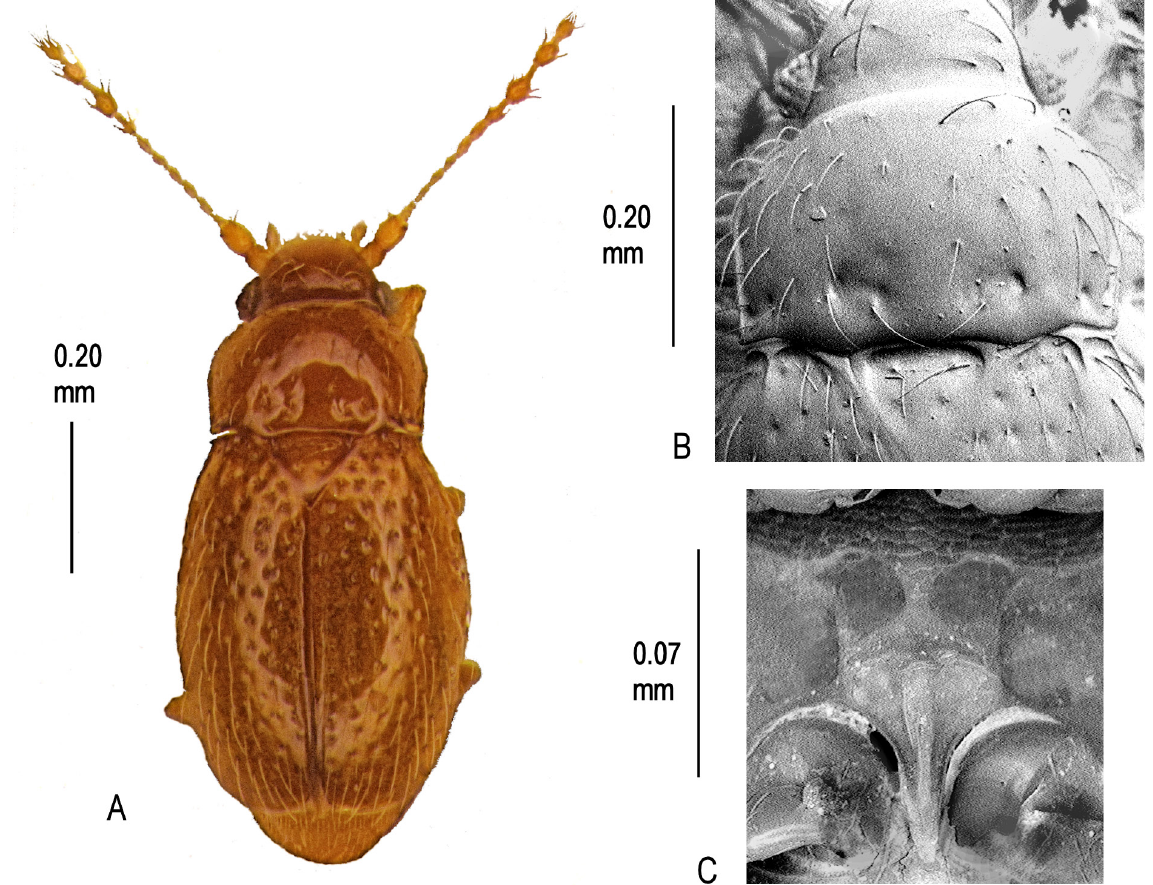
Fig. 28 . Cissidium inexspectatum sp. nov. A . Habitus. B . Pronotum, × 660. C . Mesoventrite showing median process of collar, mid-keel and keel,